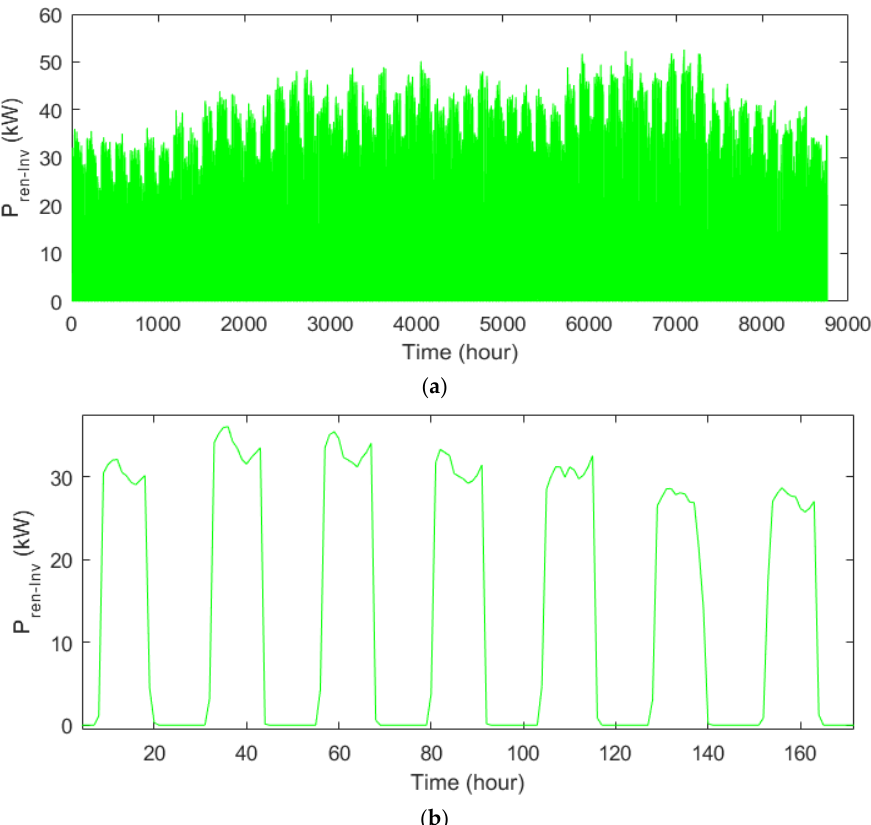
Figure 9. Delivered power to the inverter by the PV resources considered in the sizing of the HPV/FC energy system via the IAEO, considering ENSP max = 1% during ( a ) a year and ( b ) a week.